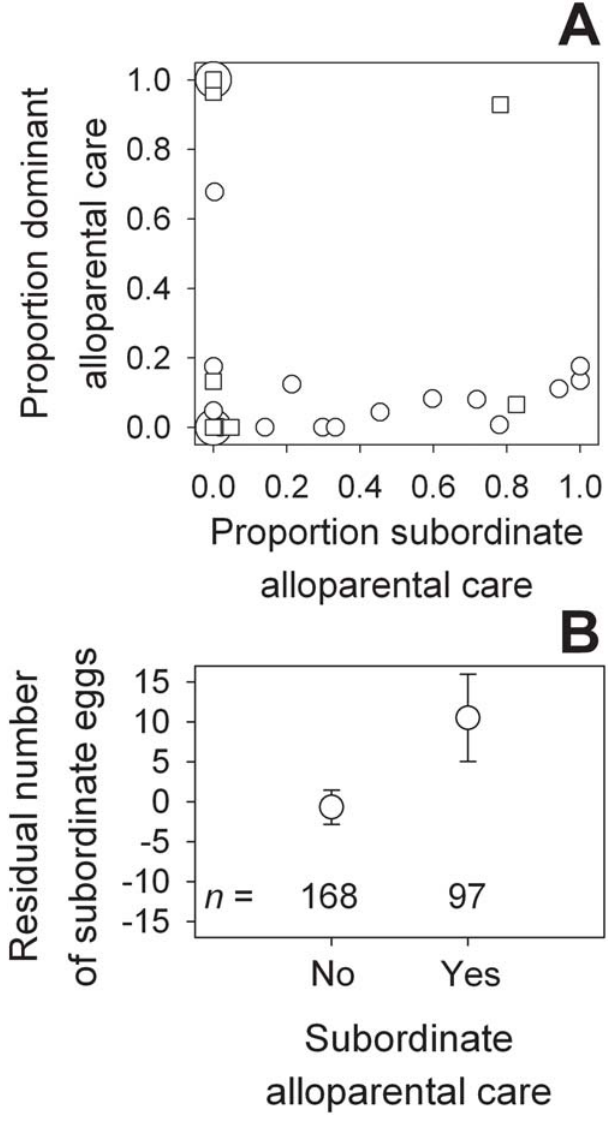
Figure 1. Reciprocity and subordinate female reproduction in N. pulcher . (A) No direct reciprocity in female cooperative cichlids: correlation between subordinate female alloparental care for domi- nant’s broods and dominant female alloparental care for subordinate’s broods ( n =26). Circles: large subordinate females vs dominant females (large symbol: two overlapping points); squares: small subordinate females vs dominant females. Proportion alloparental care is the alloparental care divided by the total care of all female group members, to correct for larger clutches receiving more care in general (see Materials and Methods and [23]). (B) Subordinate females produced more eggs when they provided alloparental brood care for the dominant females’ broods. Depicted are the residual number of eggs produced per 30 days, corrected for the other fixed and random effects (see Table